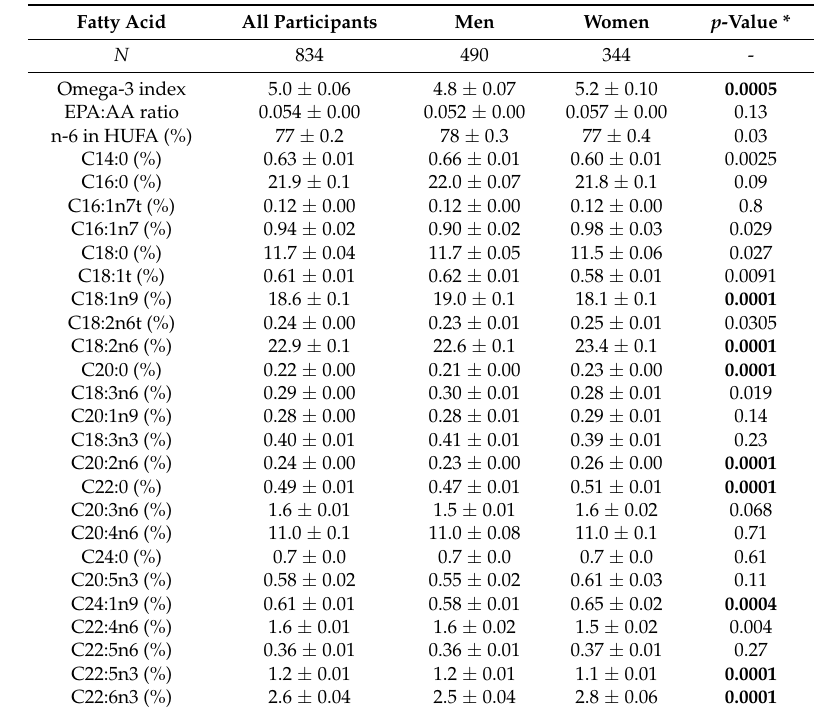
Table 3. Participant whole blood fatty acid values at the